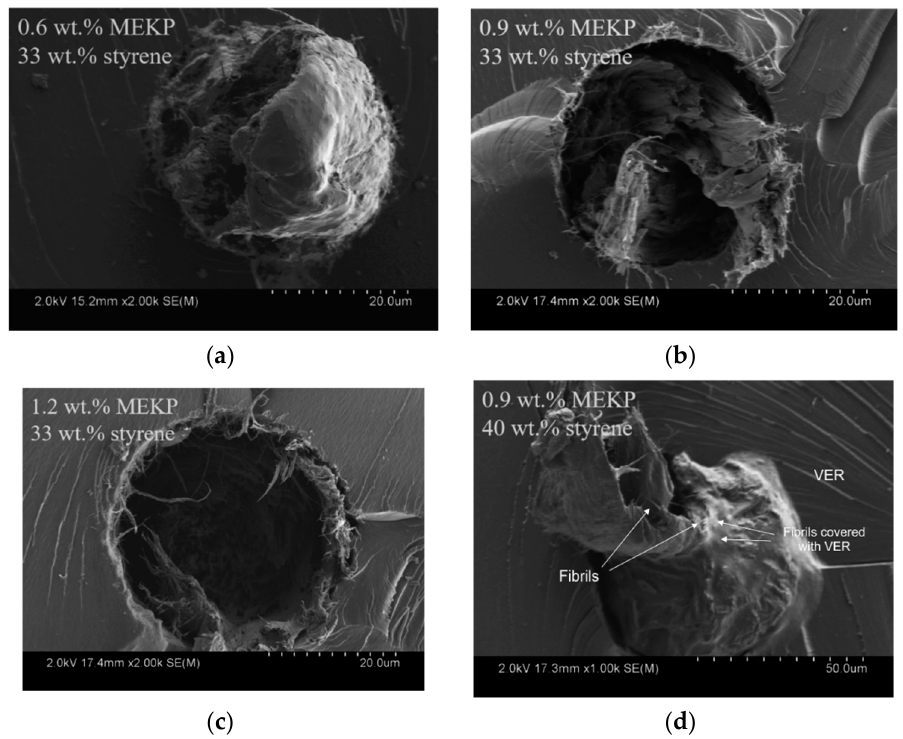
Figure 10. SEM images of solid CNTY/VER monofilament composites taken after deliberate tensile fracture: ( a ) 0.6 wt.% MEKP, ( b ) 0.9 wt.% MEKP, ( c ) 1.2 wt.% MEKP, and ( d ) 0.9 wt.% MEKP and 40 wt.% styrene.